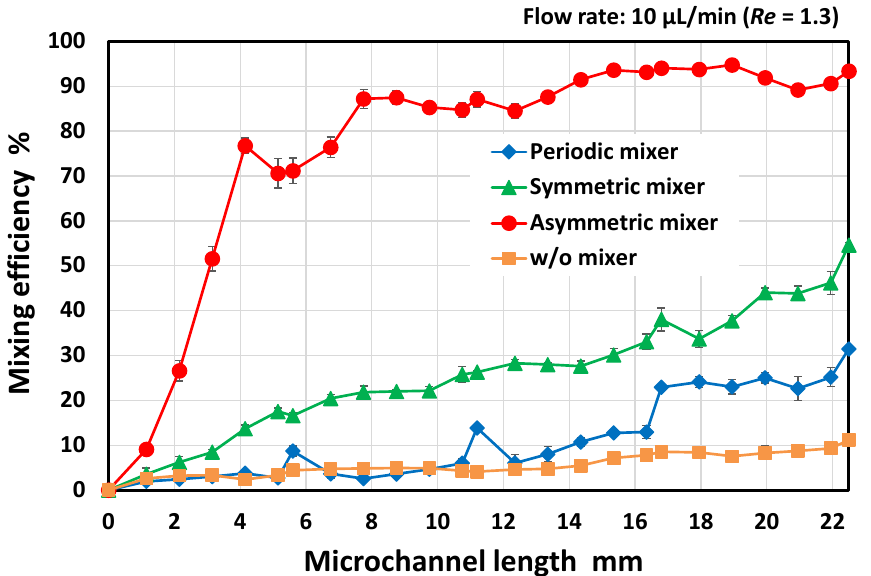
Figure 3. Experimental results showing the mixing efficiencies of the periodic mixer, symmetric mixer, and asymmetric mixer (as shown in Figure 2) as a function of the microchannel length. For comparison, the data obtained in a rectangular microchannel without obstacle structures is also plotted in the graph. Note that each point and error bar in the plot represents the mean values and standard deviations, respectively.